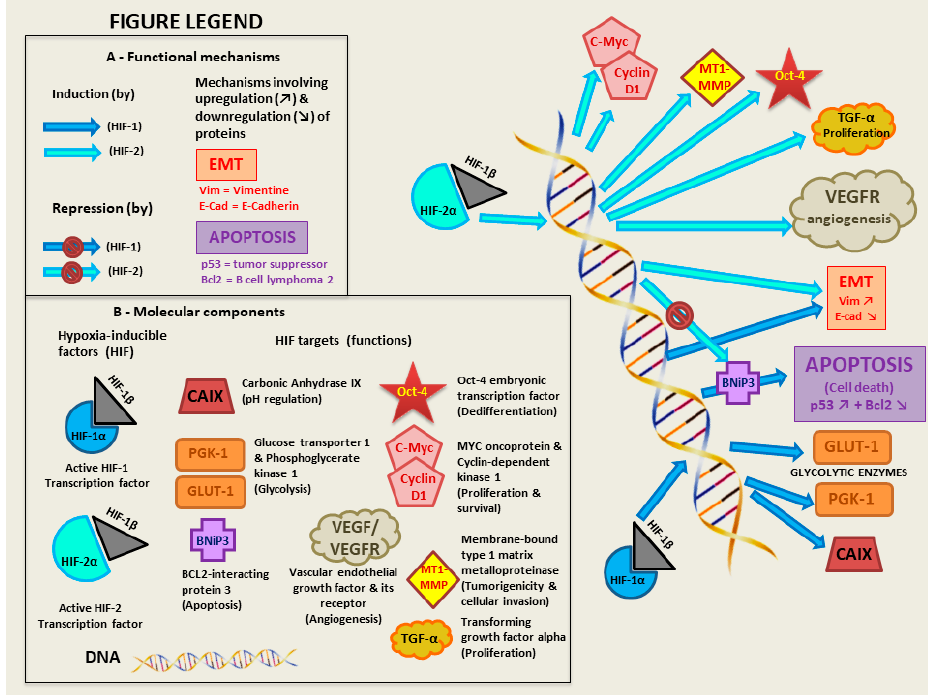
Figure 1. Molecular targets of hypoxia-inducible factors (HIF) in human kidney cells during hypoxia or in absence of functional VHL protein.